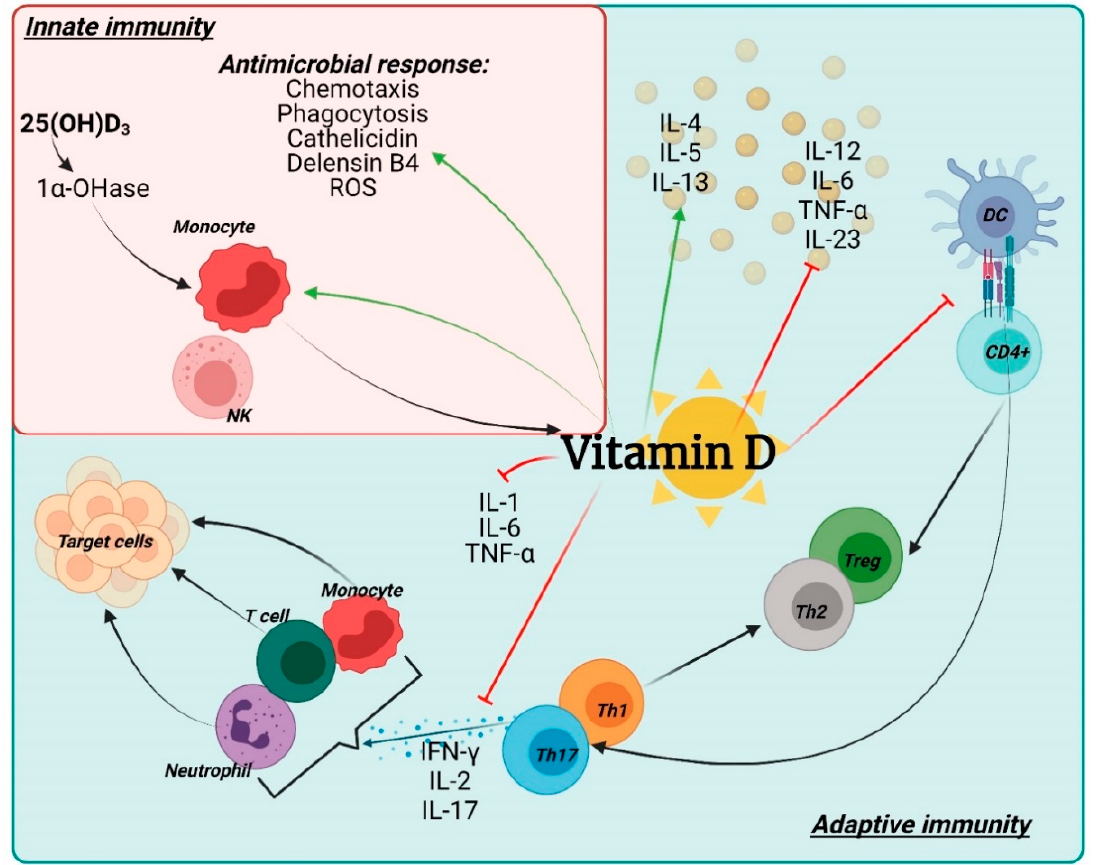
Figure 2. Vitamin D and its role on immune cells. The immunomodulatory effects of 1,25(OH)2D3 are depicted in this diagram. Different actors in the innate (red square) and adaptive immune (blue square) compartments are targeted by 1,25(OH)2D3. Vitamin D has been found to promote innate immune responses by increasing chemotaxis, antimicrobial peptides, and macrophage differentiation. Vitamin D also helps to enhance adaptive immune responses. For example, at the level of antigen-presenting cells, such as dendritic cells, vitamin D inhibits the surface expression of antigen complexed with MHCII, costimulatory molecules, and the production of cytokines IL12 and IL23, causing an indirect change in the Th1 and T-cell polarization. drives the Th17 phenotype towards a Th2 phenotype. Abbreviation: Th—T helper; NK—natural killer; DC—dendritic cells. Created with